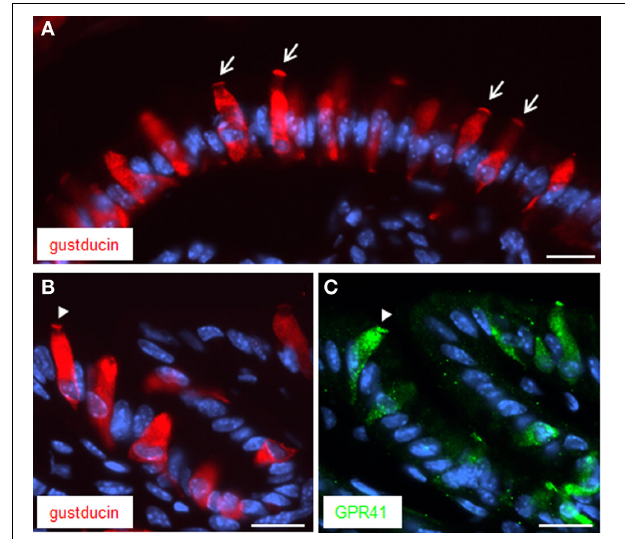
FIGURE 3 | Immunostaining for both α -gustducin and GPR41 in apical microvilli. (A) Immunostaining for α -gustducin ( red ) resulted in strong staining of the apical cell pole, in appearance reminiscent to a dense brush of microvilli (denoted by arrows ). (B,C) Treatment of consecutive tissue sections (6 μ m) yielded similar staining patterns for α -gustducin (B) and GPR41 (C) . Strong similarities between both immunostainings got evident despite fainter fluorescence intensity for GPR41-antibody. Beyond the same population of cells, both antibodies appeared to mark the same subcellular compartment, the microvilli (designated by the arrowhead ). Sections were counterstained with DAPI ( blue ). Scale bars : (A–C) = 20 μ